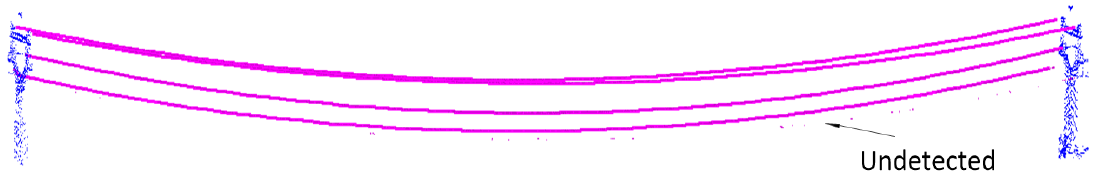
Figure 9. Power-line reconstruction results of undetected spans.